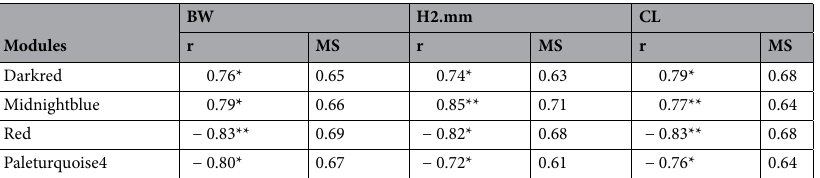
ules and traits using a heatmap plot, which graphically represents Pearson’s correlation coefficients measured between each single module and trait (Supplementary Table S1), as described in “Methods” section. Considering the huge amount of data obtained, we decided to focus on a few phenotypes and modules for subsequent analyses. In particular, we mainly considered those modules that were more significantly correlated with the 9 traits that according to Zambonelli et al. 5 were most significantly associated with WS and WB defects ( P < 0.0001 in the Student’s t-test ), i.e. breast weight (BW), the height of the breast measured at a half distance of the breast length (H2.mm), cooking loss (CL), breast length (L.mm), breast width (W.mm), marinade uptake